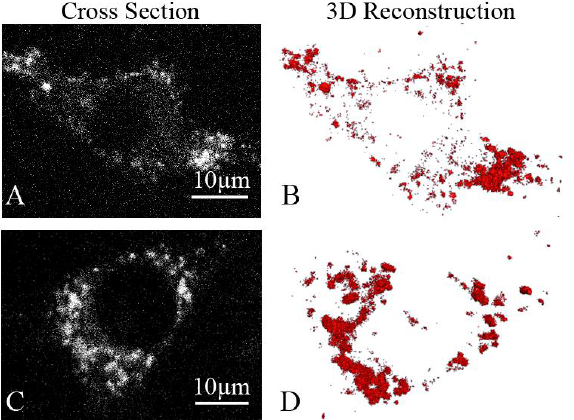
Figure 2. Three dimensional reconstruction of GLUT4-QD complex in L6 cell. L6-GLUT4myc cells were labeled with QDs as described in the method and fluorescence three-dimensional slices were acquired with a confocal microscopy system. (A) Cross section of the L6 cell at the beginning. (B) Three dimensional reconstruction of GLUT4-QDs at the beginning shown that GLUT4-QDs were located on the PM. (C) Cross section of the L6 cell after 12 h. (D) Three dimensional reconstruction of GLUT4-QDs after 12 h shown that GLUT4-QDs were internalized by endocytosis and clustered together round a conical perinuclear area. The imaging parameters were identical across the different